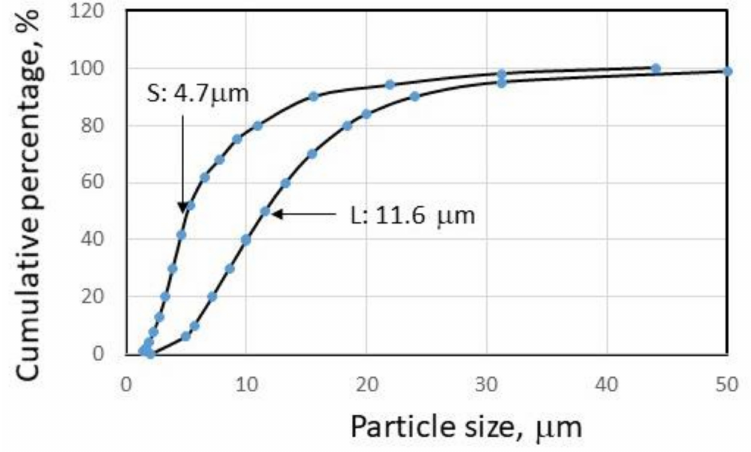
Figure 2. Cumulative particle-size distribution of ground shungite used in this experiment. Mean di- ameters (median diameter D50) of large-size particles (L) and small-size particles (S): 11.6 µ m and 4.7 µ m, respectively.